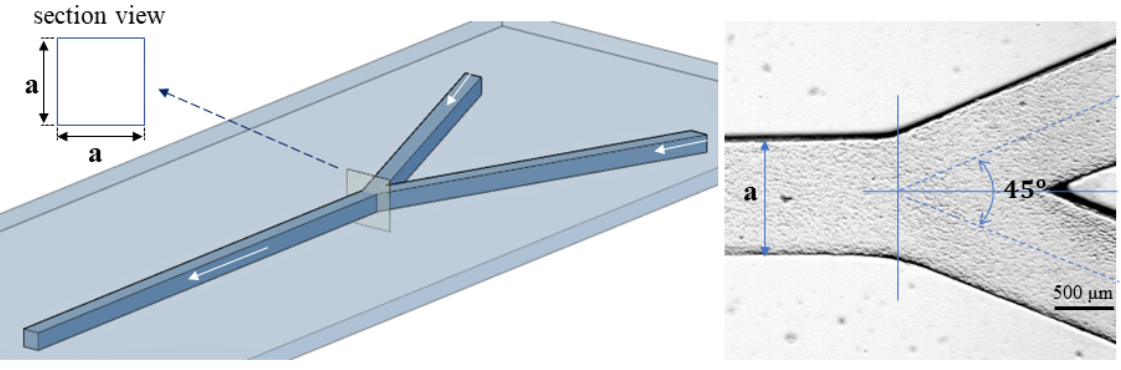
Figure 2. Geometry of the tested microchannel; microscopic detail of the Y-bifurcation with 𝑎 ≅ 1.0 mm.